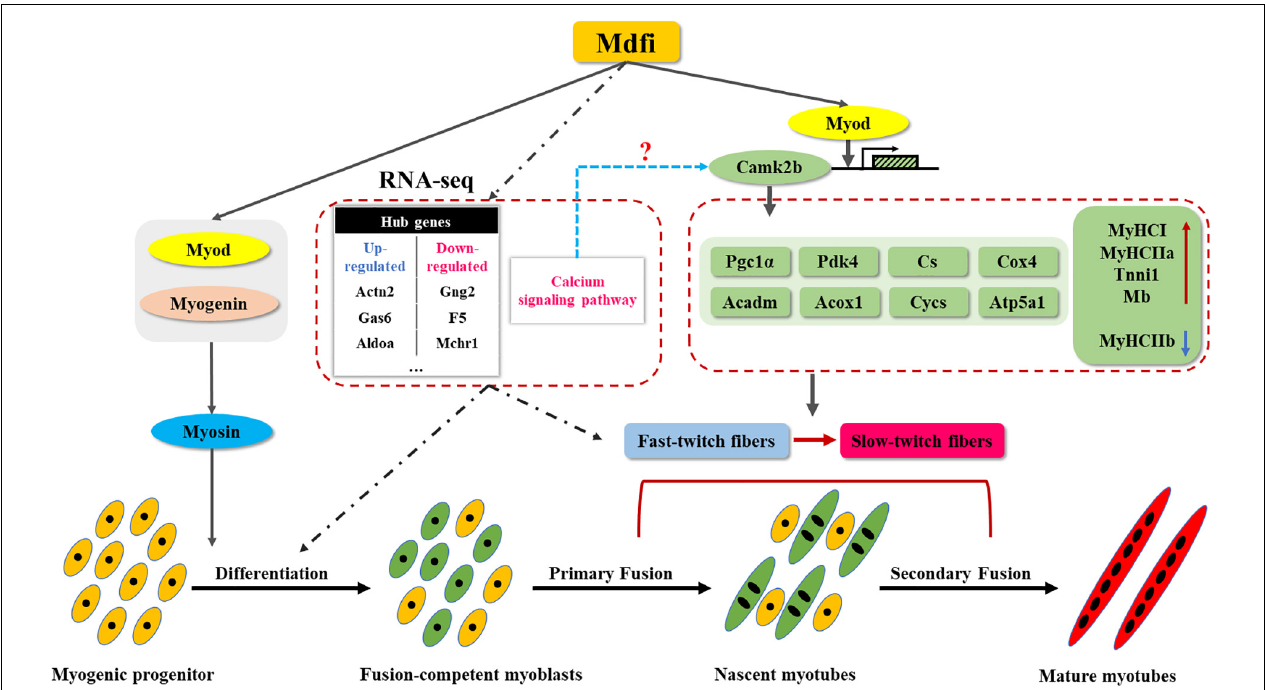
FIGURE 7 | Mdfi overexpression promoted C2C12 cell differentiation and positively modulated fast-to-slow-twitch muscle fibers transformation. We constructed a Mdfi-overexpressing C2C12 cell line by the CRISPR/Cas9 system. During C2C12 myogenic development, Mdfi promotes the differentiation of C2C12 cells by upregulating the expression of Myod, Myog, and Myosin. Mdfi positively modulated fast-to-slow-twitch muscle fibers transformation by upregulating the mRNA levels of Myod , Camk2b , and its downstream genes, such as Pgc1a , Pdk4 , Cs , Cox4 , Acadm , Acox1 , Cycs , and Atp5a1 . In addition, the calcium signaling pathway was the most significant in C2C12 cells with Mdfi-OE. We also systematically established regulatory networks and identified hub genes in them. Their regulation mechanism in Mdfi regulation of C2C12 cell differentiation and the muscle fiber type transformation warrants further investigations.